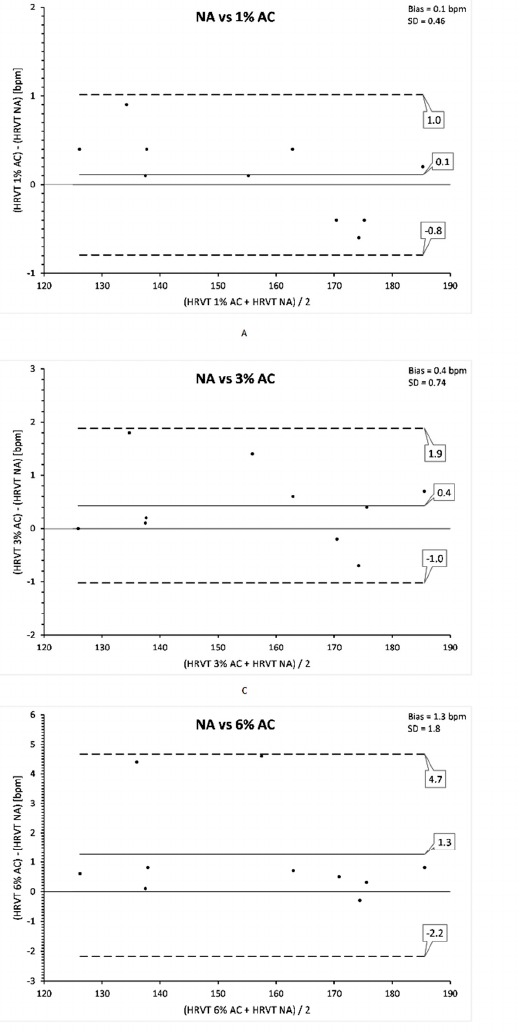
Figure 4. Bland Altman analysis of ECG derived HRVT NA vs. HRVT for each artefact condition and correction method. ( A ) vs. 1% AC; ( B ) vs. 1% MC; ( C ) vs. 3% AC; ( D ) vs. 3% MC; ( E ) vs. 6% AC; ( F ) vs. 6% MC. Center solid line in each plot represents the mean bias (difference) between each paired value. The top and bottom lines are 1.96 standard deviations from the mean difference. Net bias with standard deviation (SD) in top right portion of each plot.